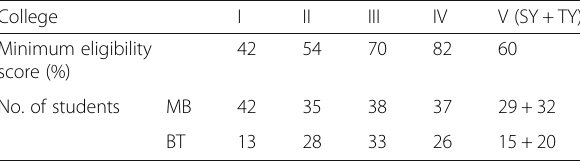
Table 1 College wise data on the number of participating students and stated minimum eligibility